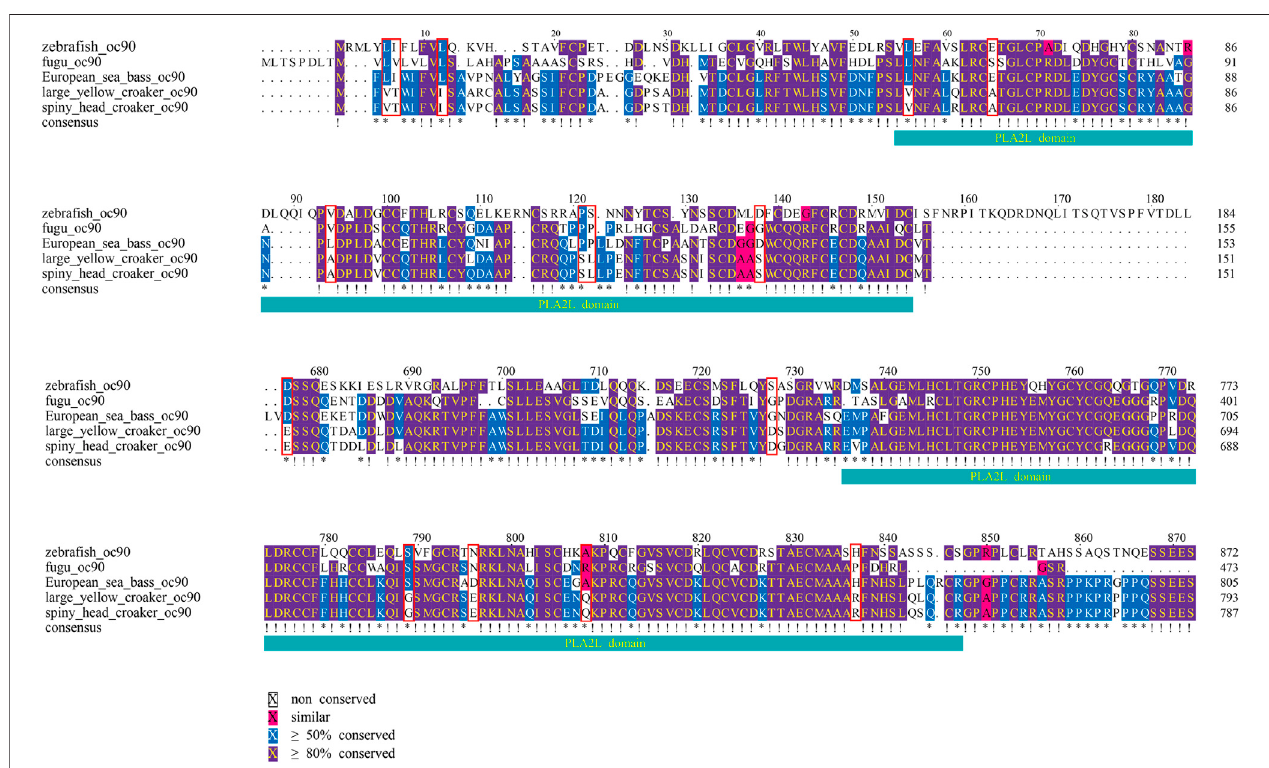
FIGURE 7 | Multiple alignments of partial Oc90 sequences. Red boxes mark the changed amino residues at two PLA2L domains of the Oc90 from the family Sciaenidae.